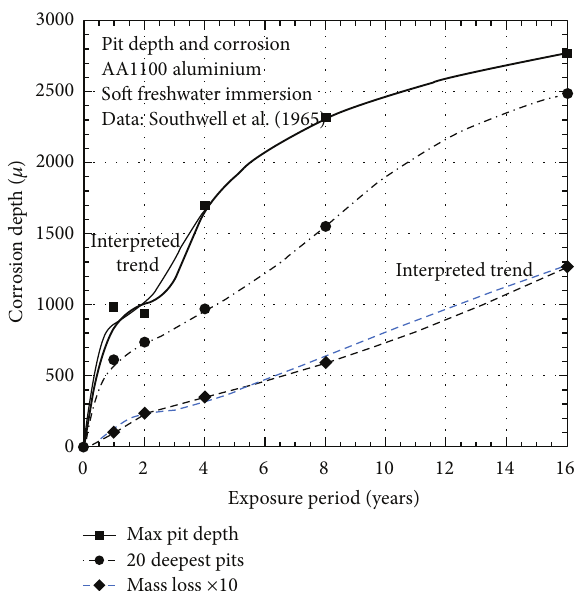
Figure 12: Data and fitted trends for AA6061-T exposed to fresh- water immersion conditions (Gatun Lake, PCZ). The changeover to mode 2 occurs at around 4 years of exposure. Data from Southwell et al.